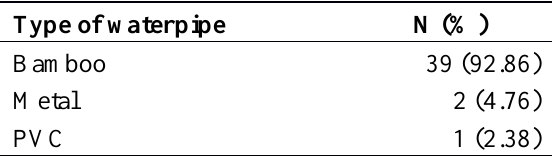
Table 2. Prevalence of Waterpipe